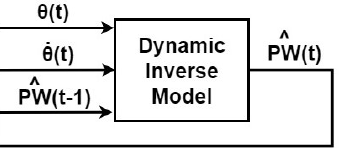
Figure 2. Inverse dynamic NARXNN configuration used under real-time and validation conditions.